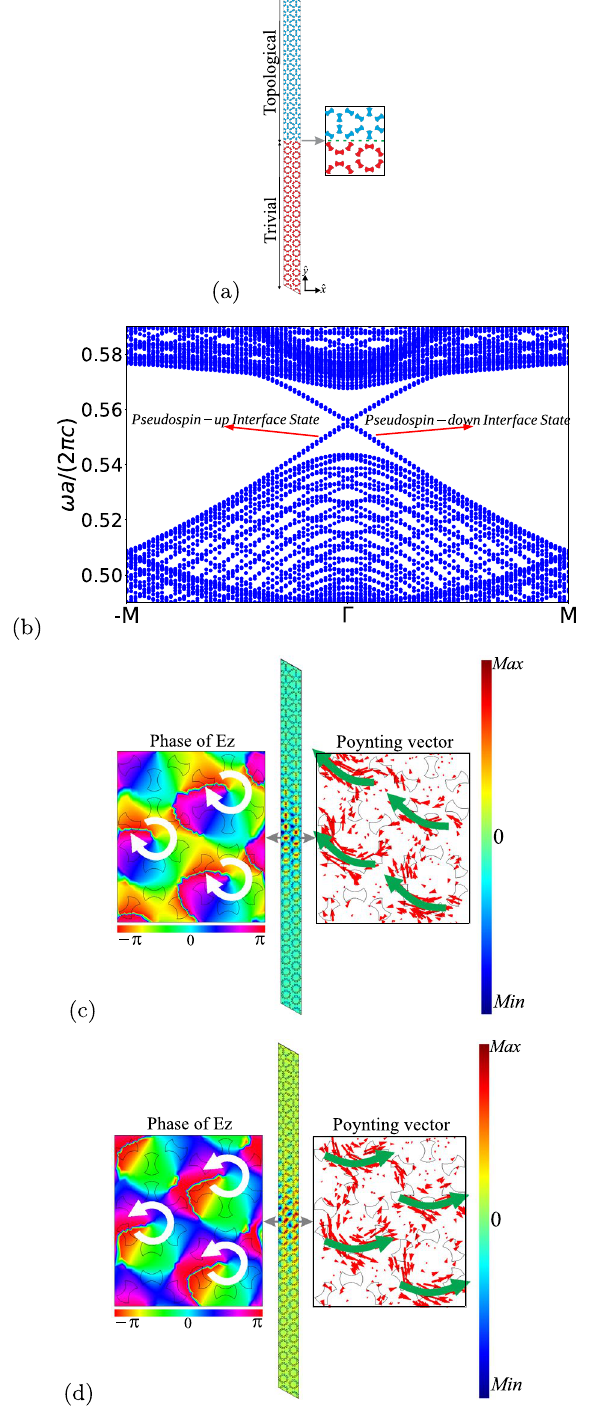
Figure 7. Results for a sample composed of topological and trivial photonic crystals. ( a ) Schematic of the π/ 4 ) and 15 topological unit cells ( φ supercell with 15 trivial unit cells ( φ = − M direction for TM modes. We can observe two interface modes in Projected band structure along the Ŵ → the gap. ( c ) Spacial distribution of E z , the time-averaged Poynting vector (right), and phase distribution (left), 0.015 k 0 . ( d ) The same for for ω a /( 2 π c ) 0.5532 at k x for ω a /( 2 π c ) = =